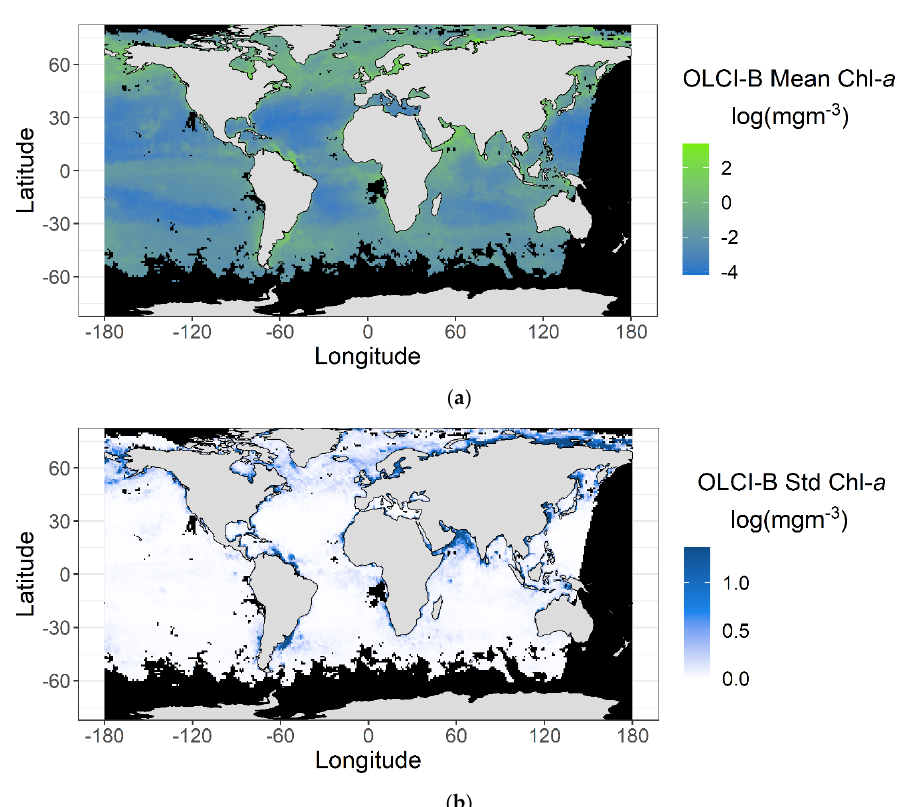
Figure 5. Global maps at 1° resolution of the OLCI-B chl- a ( a ) mean and ( b ) standard deviation over the tandem period. See Appendix D for similar maps produced for OLCI-A-Aligned and OLCI-A-Vicarious. Black grid cells indicate missing data.